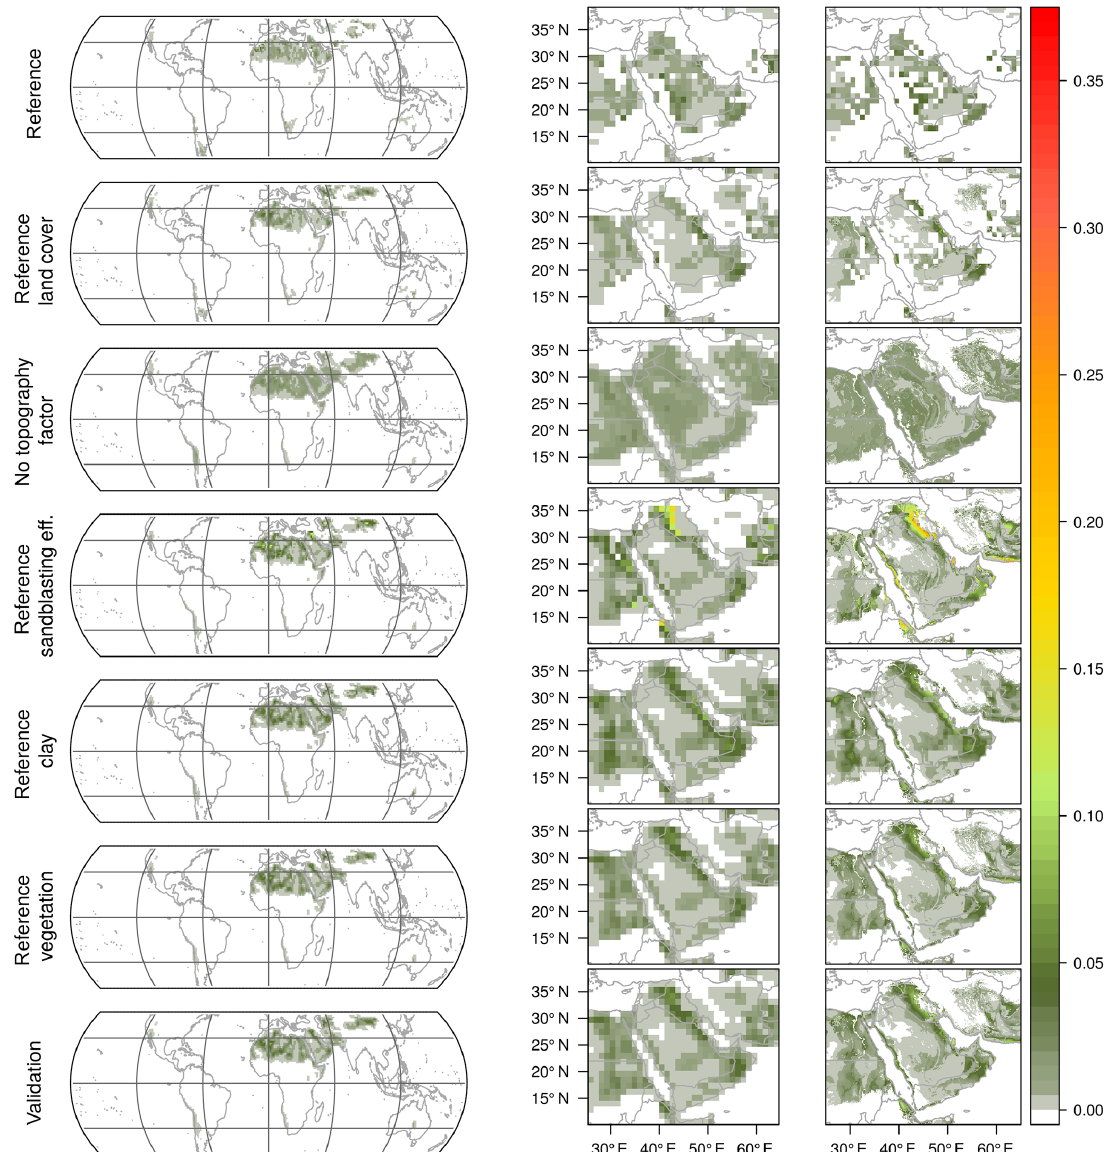
Figure 7. Distribution of the emission factor a · f landcover · f veg · N S topo during July 2011 for (from top to bottom) the original emission scheme, the revised emission scheme but using the reference land cover data, no topography factor, the reference sandblasting efficiency, clay fraction or vegetation, and the revised emissions. For the first and second columns from the left, all data have been regridded to T106 resolution; the third column showing the Middle East illustrates the effect of using the full resolution of the revised input